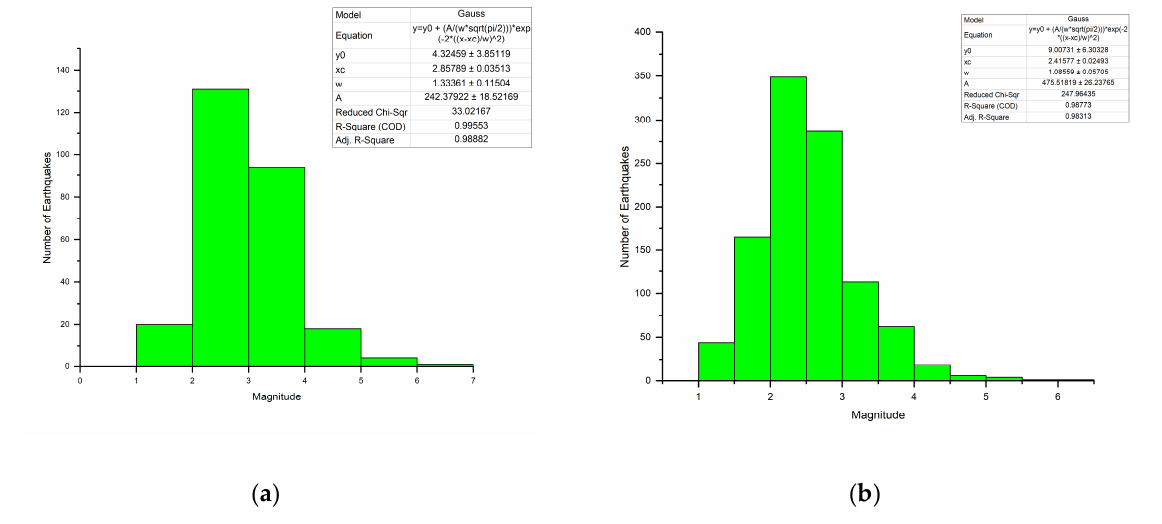
Figure 7. ( a ) Magnitude distribution of the aftershocks recorded for the first 24 h after the ML 6.0, number of events (Nr) = 268; ( b ) the distribution of magnitudes concerning the number of earthquakes for the first month after the main event. Nr = 2062.